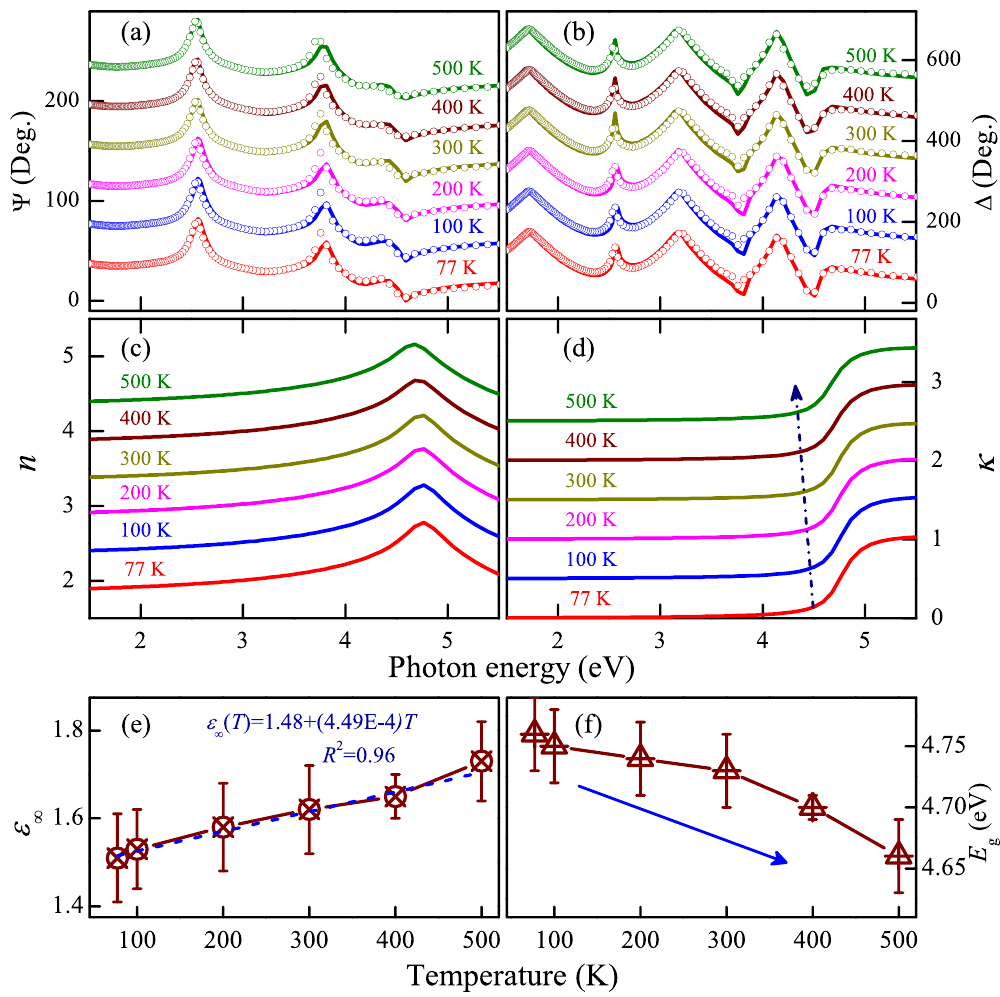
Figure 6. The NIR-UV experimental (dotted lines) and best-fitted (solid lines) ellipsometric spectra ( a ) Ψ ( E ) and ( b ) Δ ( E ) of KN-Pt under 77, 100, 200, 300, 400 and 500 K. Evolution of ( c ) refractive index ( n ) and ( d ) extinction coefficient ( κ ) of KN-Pt with increasing the temperature. For clarity, the arrow indicates the absorption edge redshift with increasing the temperature. Note that Ψ , Δ , n and κ are vertically shifted by adding 40, 100, 0.5 and 0.5, respectively.